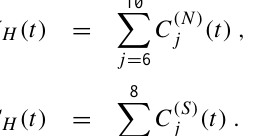
Table 1. Characteristic periods of the significant IMFs obtained for the EDML and NGRIP data sets through the EMD. Errors are esti- mated as standard deviations of the instantaneous periods. The pe- riod T 16 calculated for the j = 16 NGRIP mode is not reported as it is not sufficiently shorter than the time series length, although the mode is